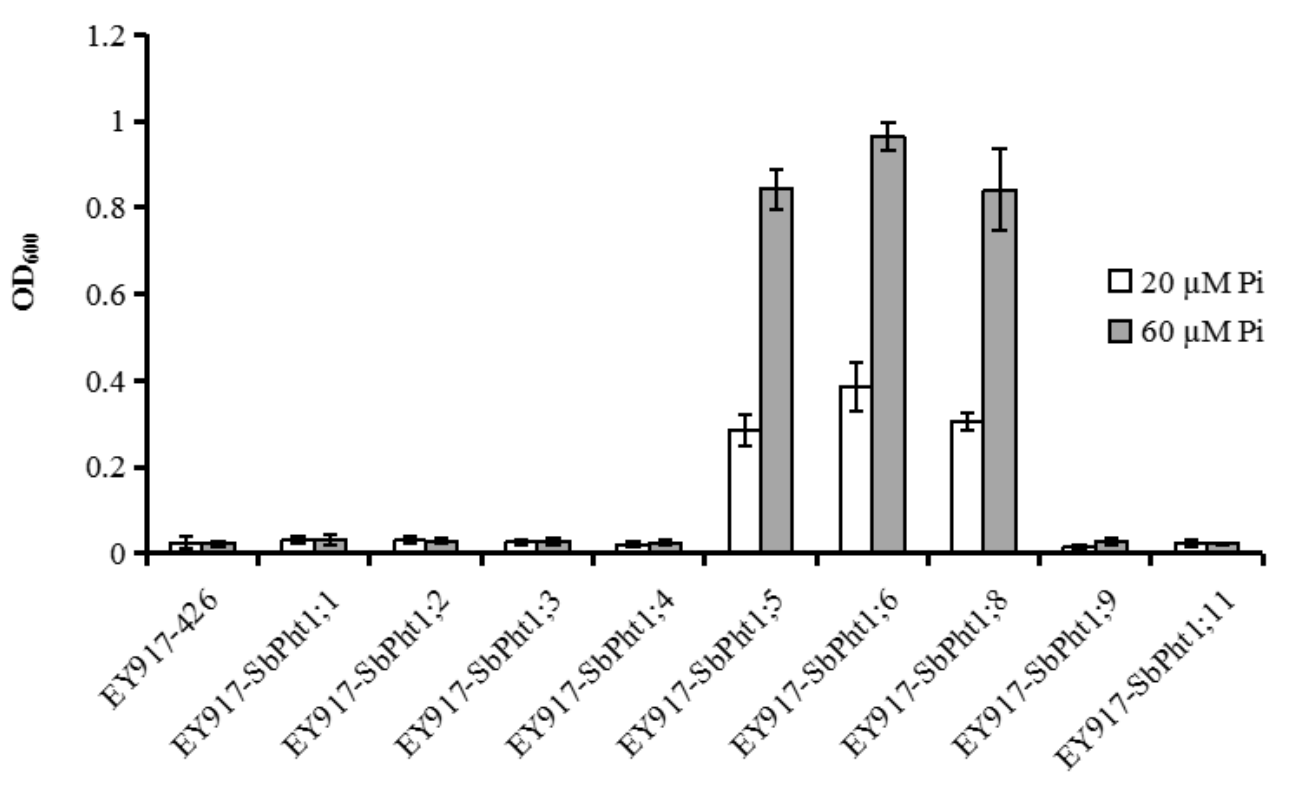
Figure 7. Functional complementation of nine SbPht1 genes by ectopic expression in yeast mutant strain EY917 under P-deficient conditions.